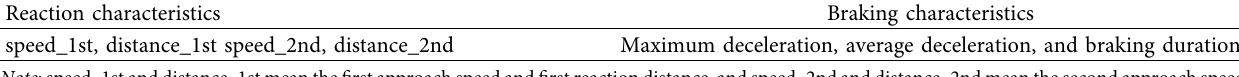
Table 3: Parameters of reaction characteristics and braking